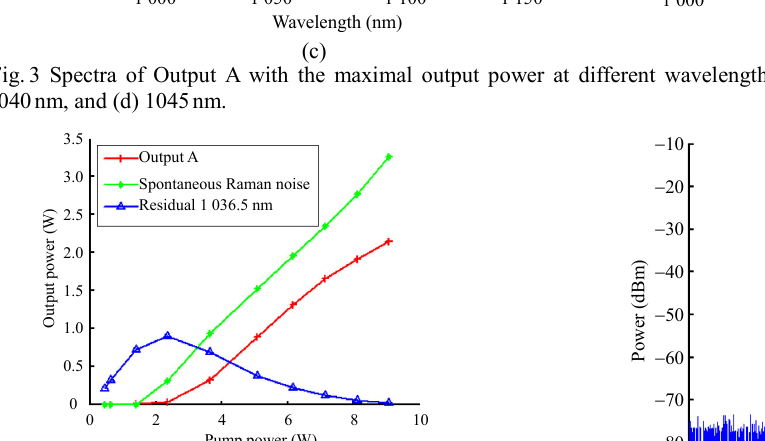
Fig. 4 Powers of Output A, spontaneous Raman scattering noise from Output B, and residual 1036.5 nm versus pump power.